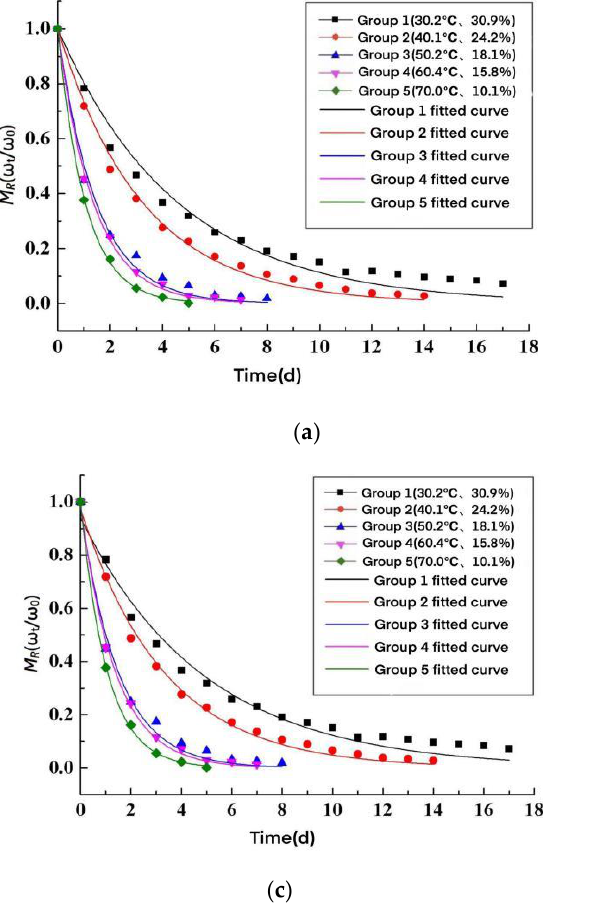
Table 6. Model-fit determinable coefficient ( R 2 ).